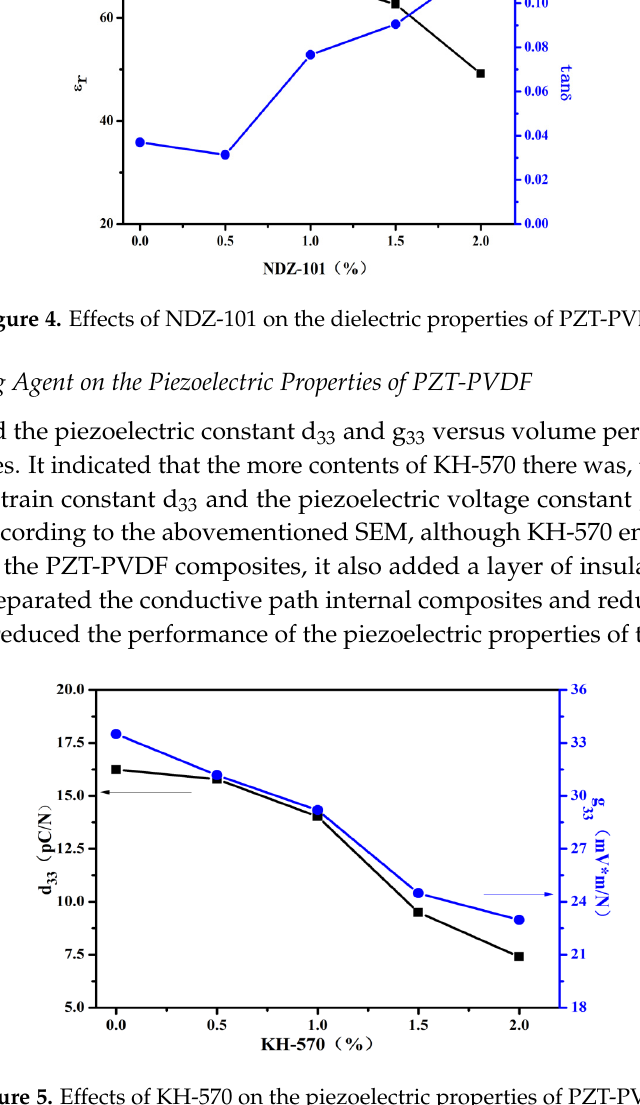
Figure 5. Effects of KH ‐ 570 on the piezoelectric properties of PZT ‐ PVDF.